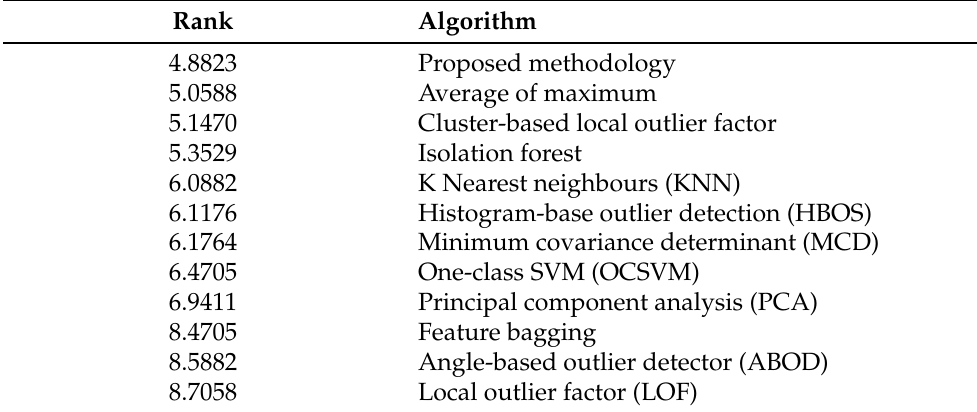
Table 1. Friedman comparison for